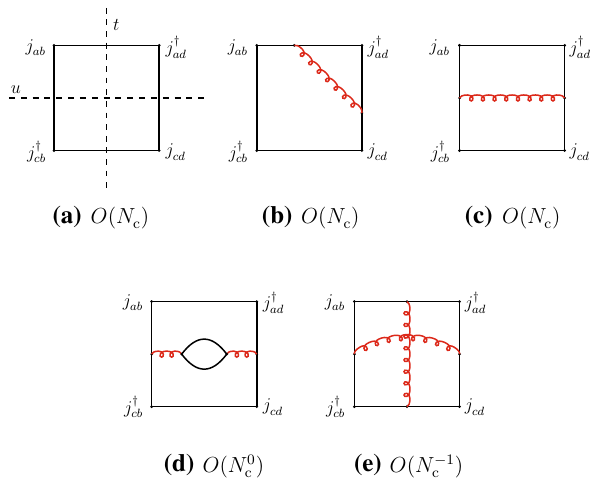
Fig. 5 Leading-order meson diagrams in the recombination channel; diagrams of the type of Fig. 2d contribute as meson loop radiative cor- rections or as a meson–cryptoexotic tetraquark mixing to diagram (c)